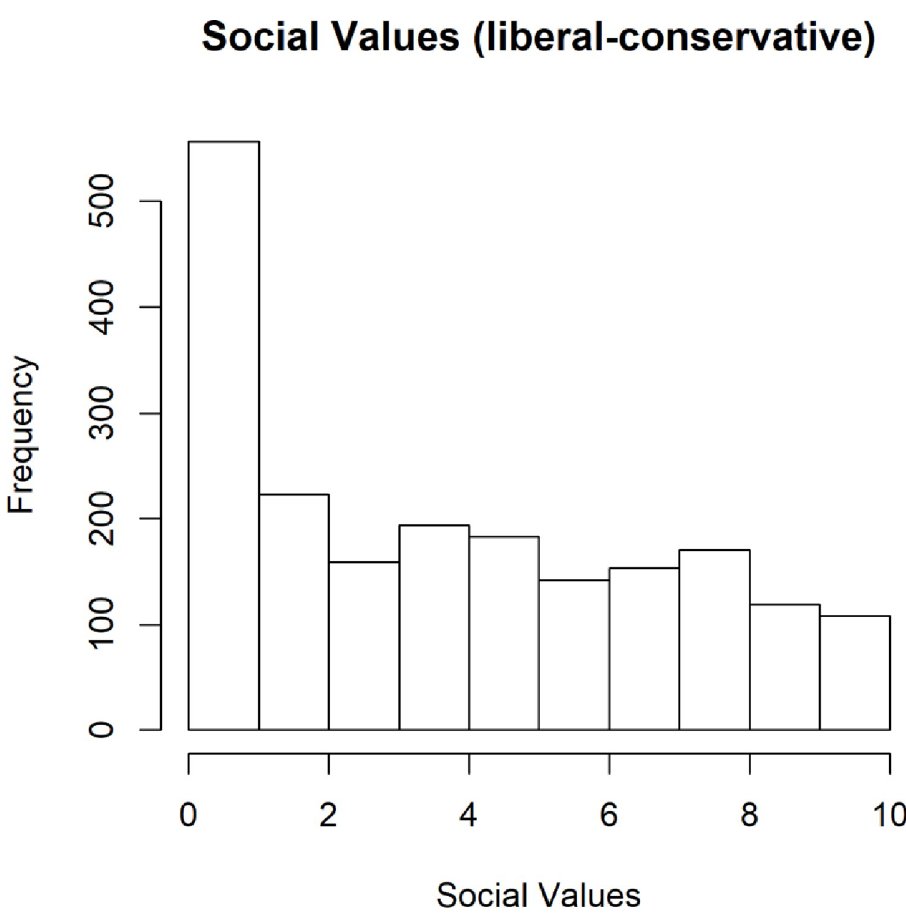
Fig 5. Distribution of social political values (0- most liberal; 10-most